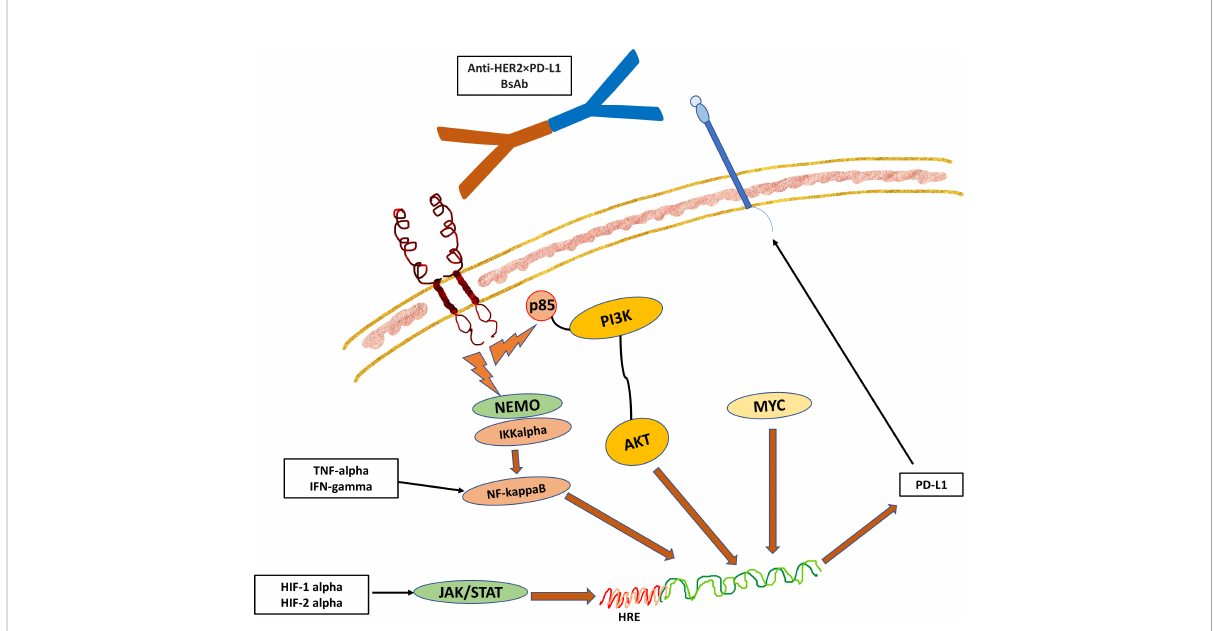
FIGURE 2 The Hypothesized Role of NF-kappaB Pathway in the Regulation of the Immune Checkpoint Pathway. The downstream signal of receptor activation triggers the translocation of NF-kappaB into the nucleus, which then binds to the promoter region of the PD-L1 gene (27). In addition, the changes in the dynamics of the tumor microenvironment such as hypoxia and cell stress with surge of pro-in fl ammatory cytokines such as TNF-alpha and IFN-gamma can also drive the NF-kappaB pathway to induce the expression of PD-L1 in cancer cells or TILs. While there is an association of HER2 expression with PD-1/PD-L1 pathway, the exact mechanisms that link the two together remain to be elucidated. However, it is likely that PD-L1 expression indicates epithelial-mesenchymal transition (EMT) in cancers to protect mesenchymal cells and stem cells from immune attack. This hypothesized crosslink activity between HER and PD-L1 forms the basis of development of BsAb targeting both HER2 and